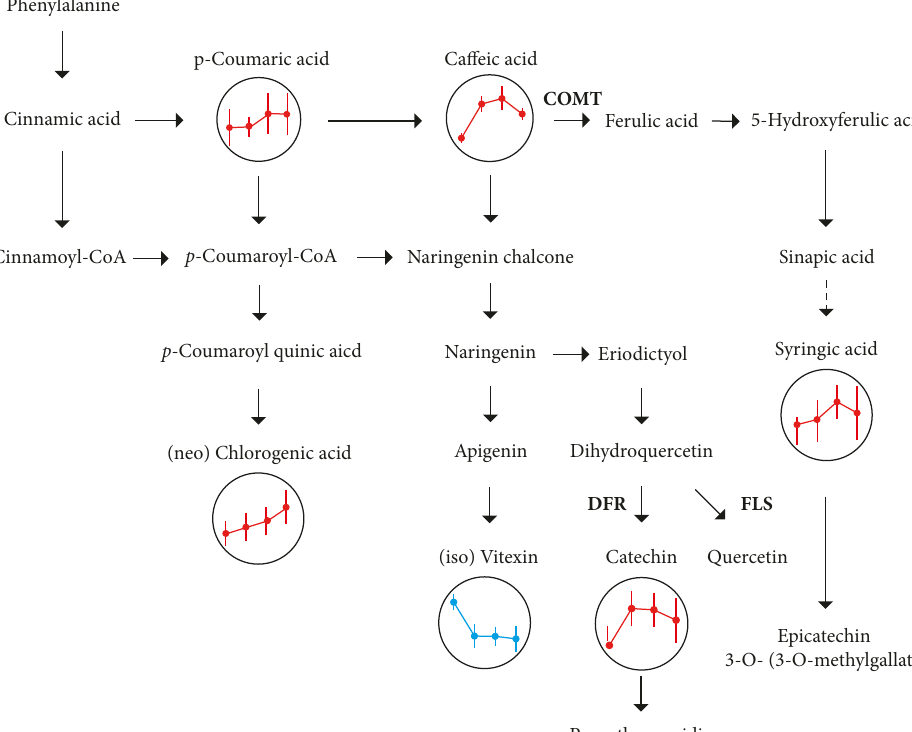
Figure 6: Schematic illustration of metabolic evolution of mung bean sprouts on the biosynthetic pathway during germination. Graphs in the circle show the changes of metabolites from day 1 to day 4 after germination. The dotted line indicates enzymic reaction that has not been fully identified in plants. COMT, DFR, and FLS are the caffeic acid 3-O-methyltransferase, dihydroflavonol, and flavonol synthase,